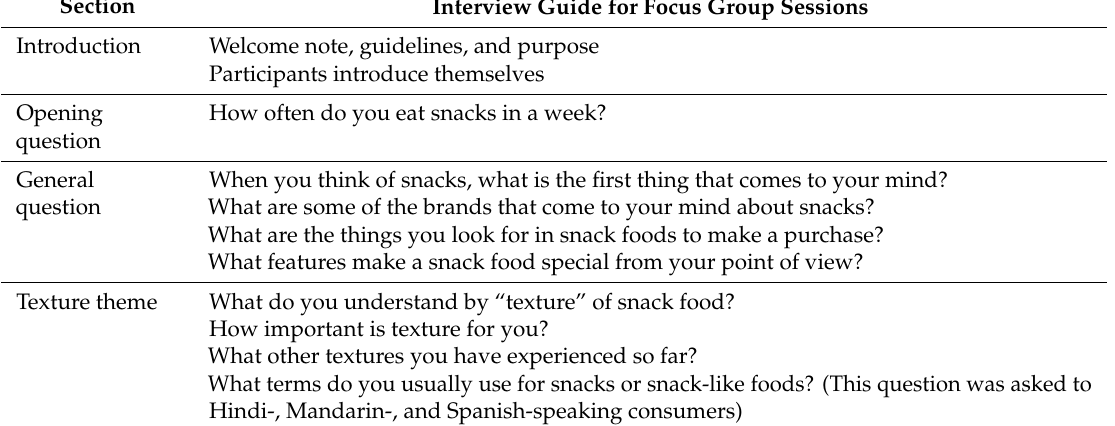
Table 3. Abbreviated interview guide with introduction and themes covered by the moderator in the focus group